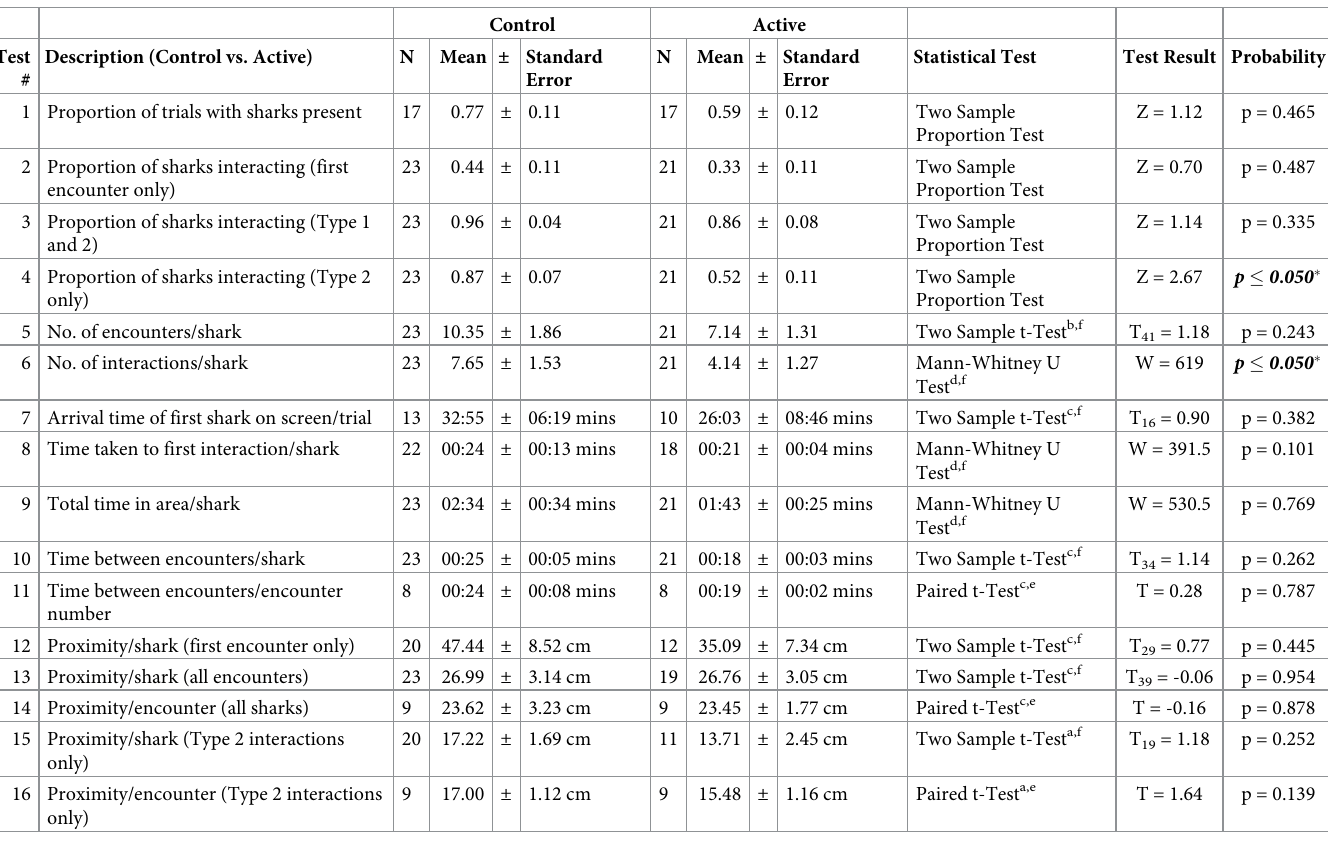
Table 2. Comparison of the behavioural response of C . carcharias when encountering an inactive (control) or active ESDS. For more detailed data, see S1 Table. Justi- fication for the statistical tests used is provided below. Control